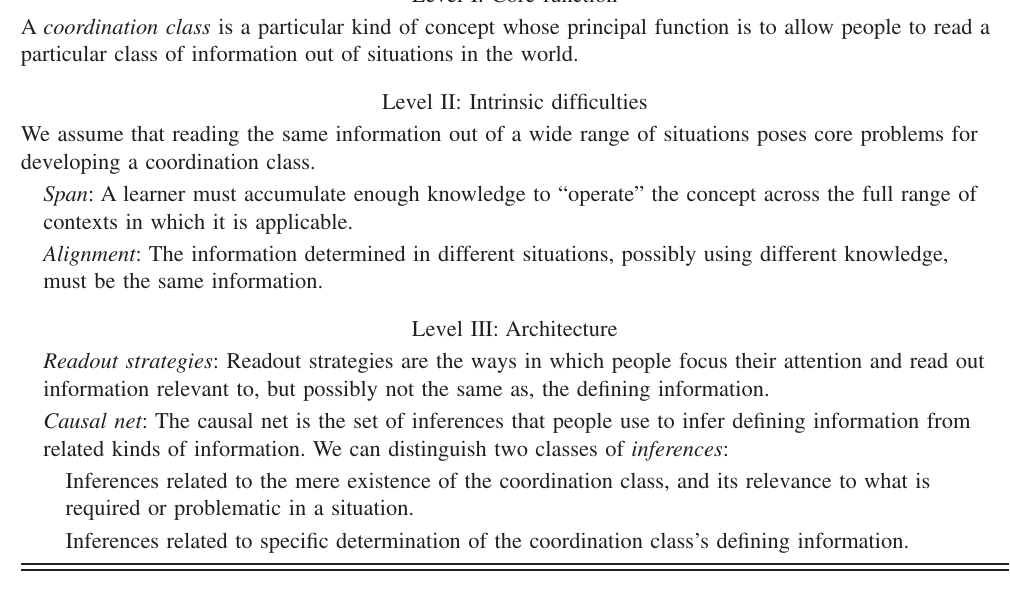
TABLE I. Summary of the main elements of coordination classes. (cid:1) Adapted from diSessa and Wagner (cid:1) Ref. 13 (cid:2) . Used with permission.